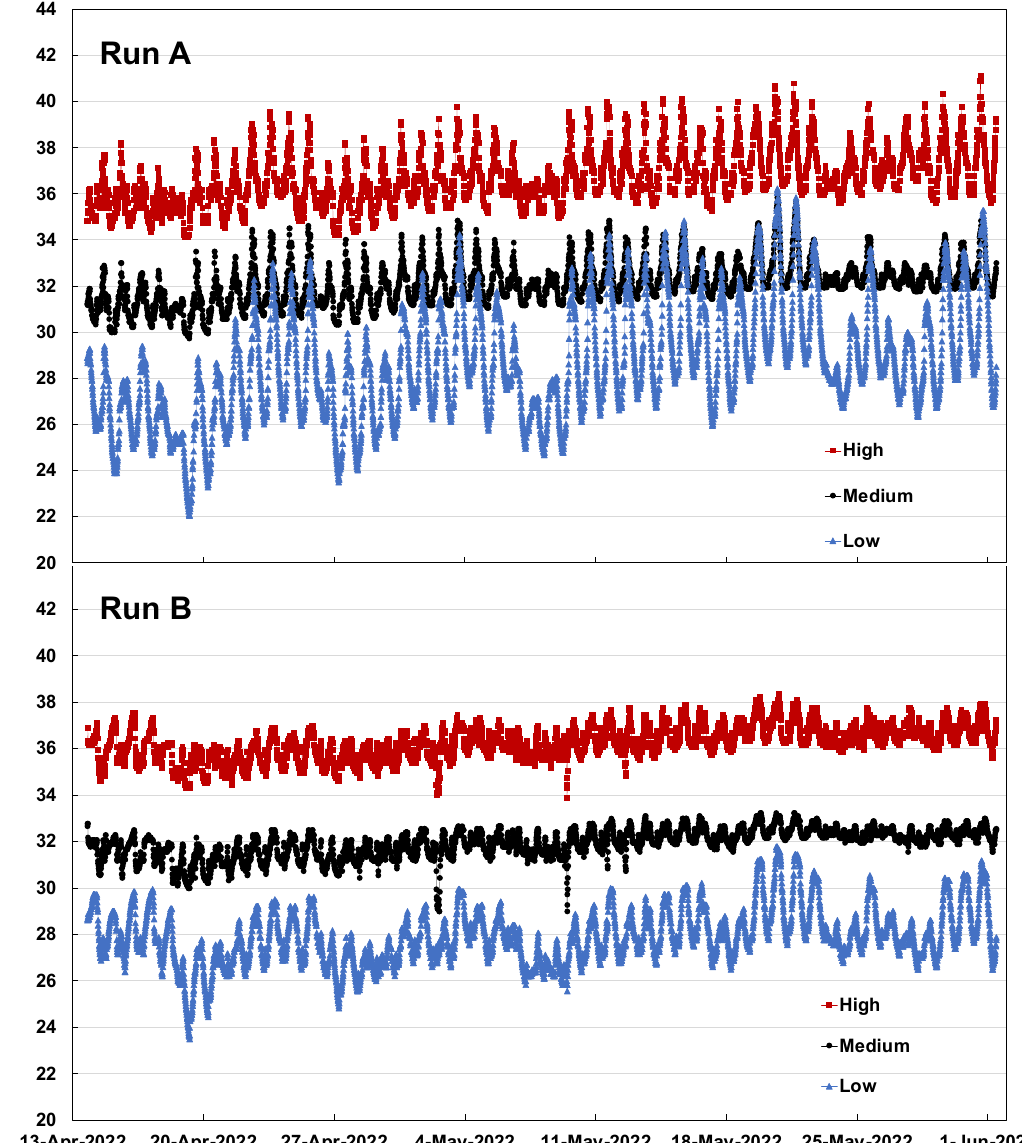
Figure 2. Soil temperature at a 5 cm depth collected at 15 min intervals (Item #3667-20, #3688WD1, Spectrum Technologies, Aurora, IL, USA) in the high-, medium-, and low-soil-temperature treatments while establishing ‘Prizm’ zoysiagrass ( Zoysia matrella (L.) Merr.) from sprigs. Experimental runs were conducted in glasshouses in Knoxville, TN in 2022.